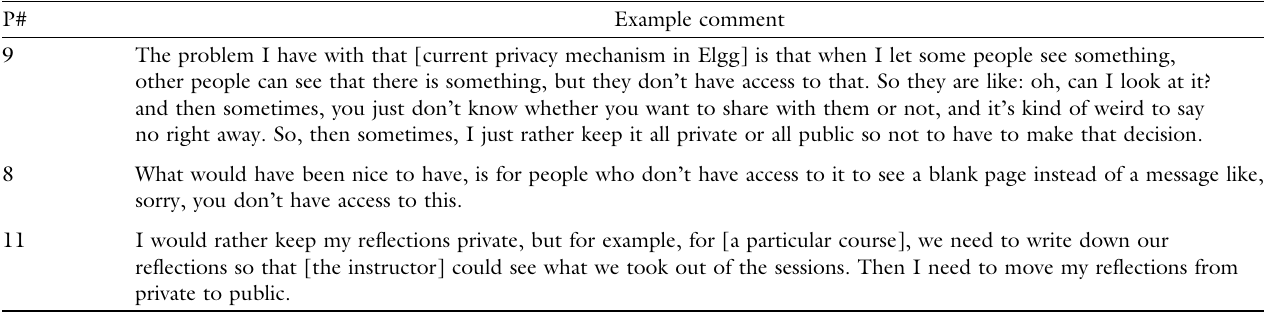
Table 4. Sample user quotes on privacy factors—change of